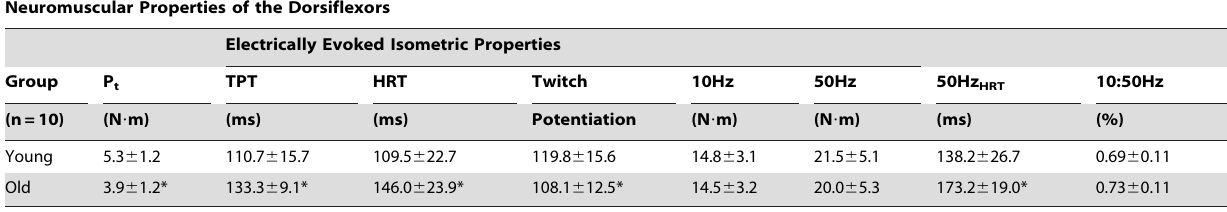
Table 1. Electrically evoked neuromuscular properties of the